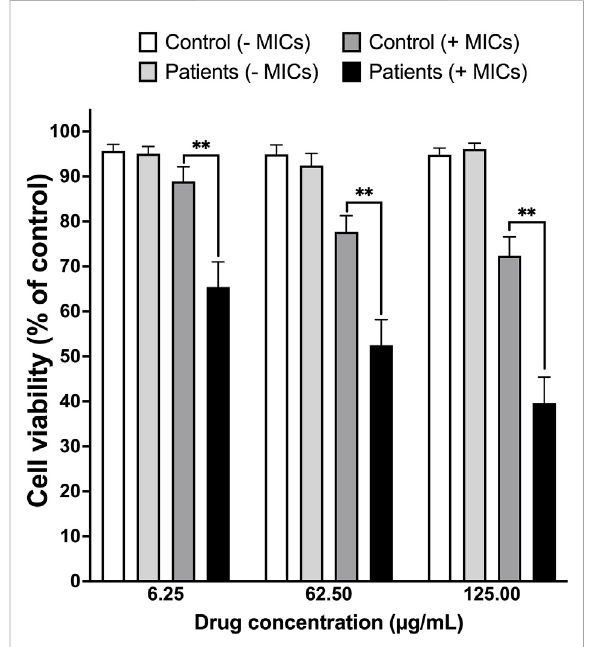
FIGURE 1 Summary of the LTA test results for 20 SSLR patients and 20 healthy controls. Lymphocytes isolated from health controls were incubated with drug either without microsomes (MICs, white bars) or with drug and MICs (light grey bars) and cells isolated from SSLR patients were incubated with drug either without MICs (dark grey bars) or with MICs (black bars). Y axis represents cell viability expressed as a percentage from incubating the corresponding cells with control vehicle without the drug. **, p < 0.001.